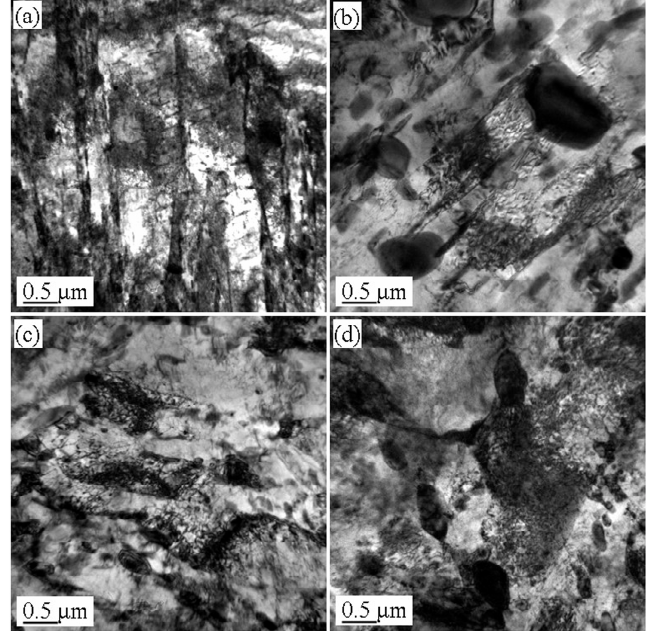
Figure 6. Microstructure of tempered 5140 steel tempered at 560 °C before and after different accumulated proton irradiation observed by TEM pictures of ( a ) 0 protons/cm 2 , ( b ) 2 × 10 14 protons/cm 2 , ( c ) 2 × 10 15 protons/cm 2 , ( d ) 2 × 10 16 protons/cm 2 .